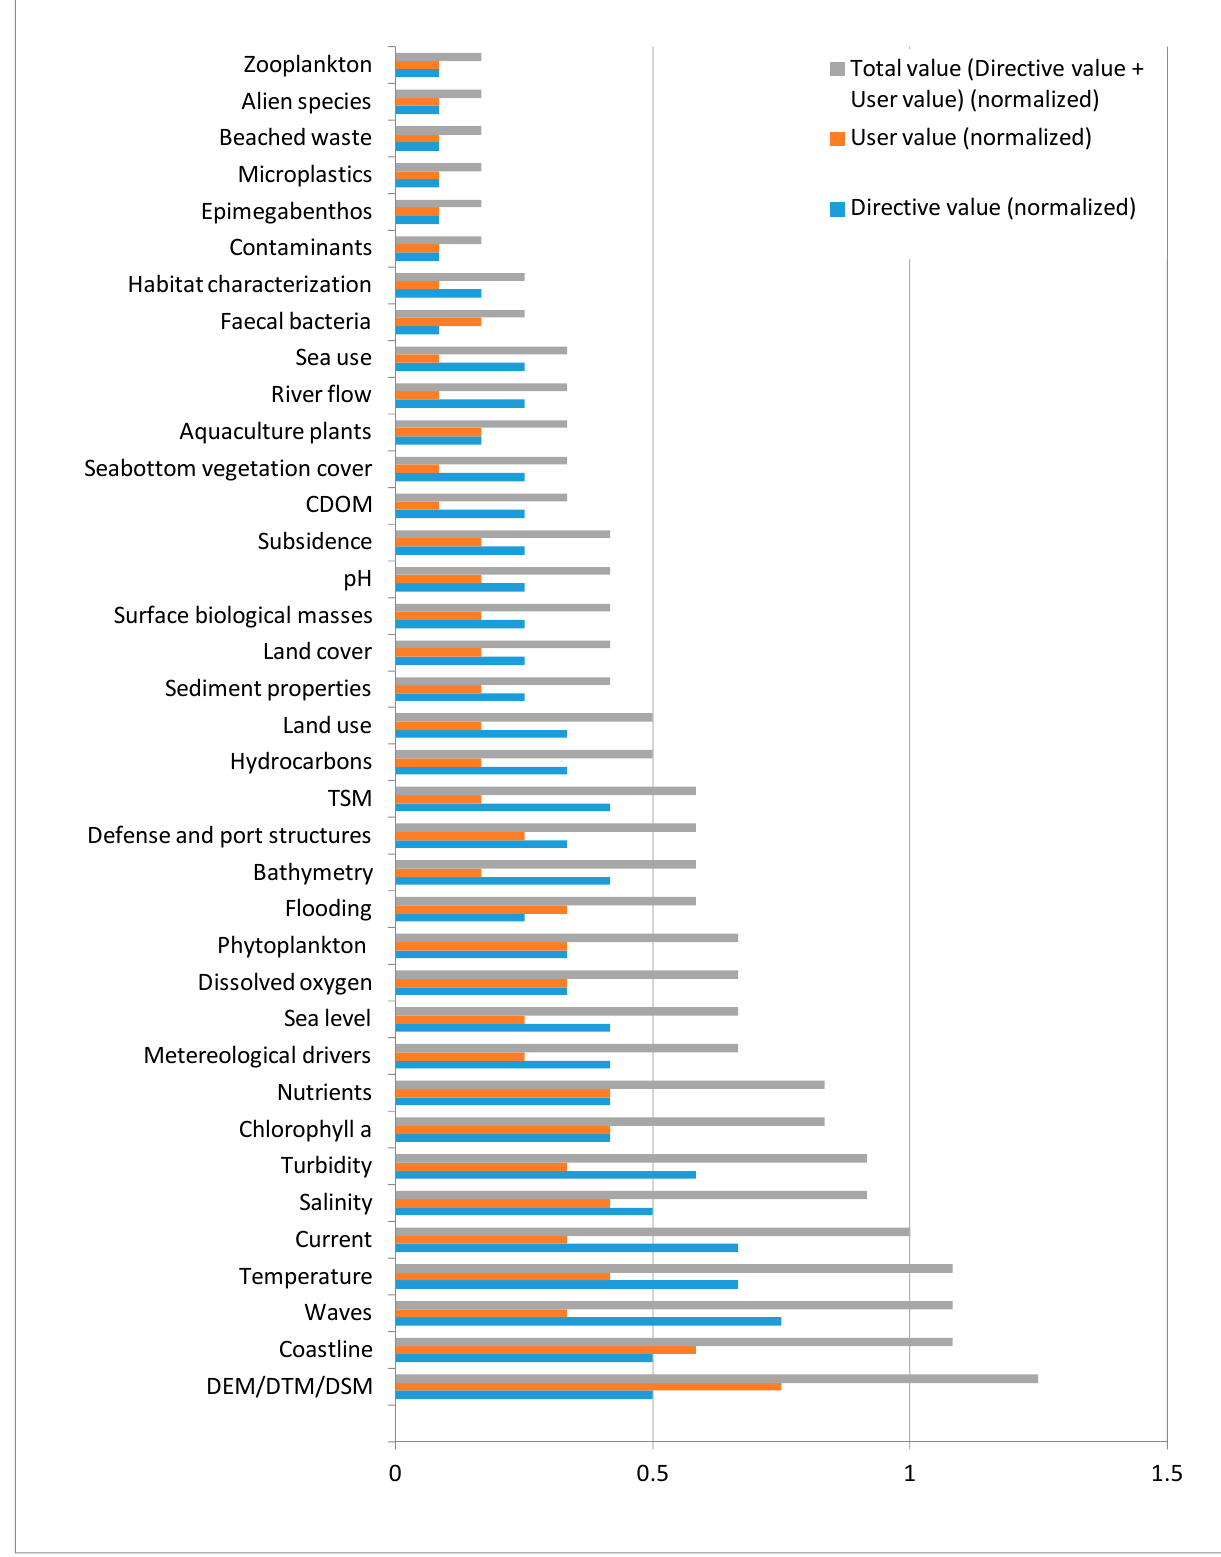
Figure 4. Parameter values calculated with the Formula (3).